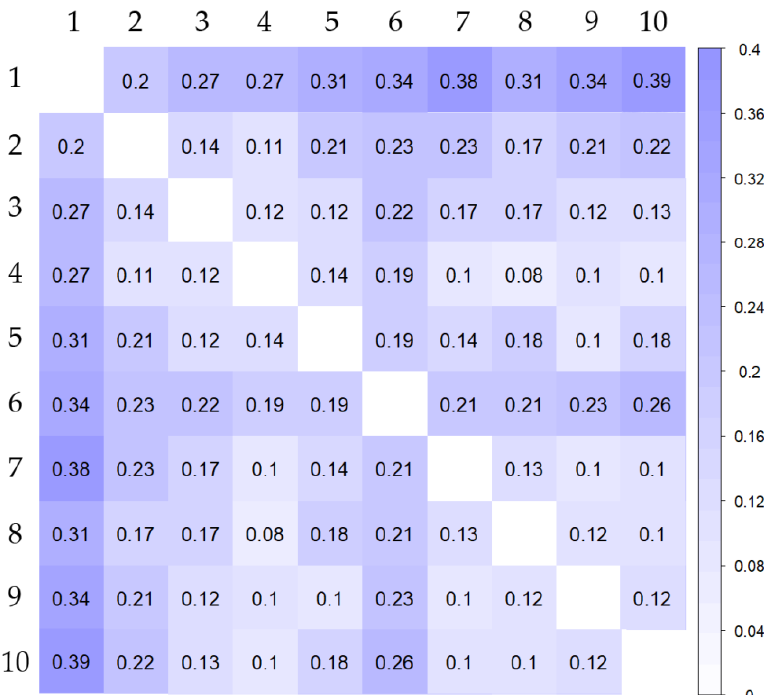
Figure 4. Corrplot of pairwise F ST values calculated among populations identified by DAPC using “hierfstat” v. 0.5–7 R package.